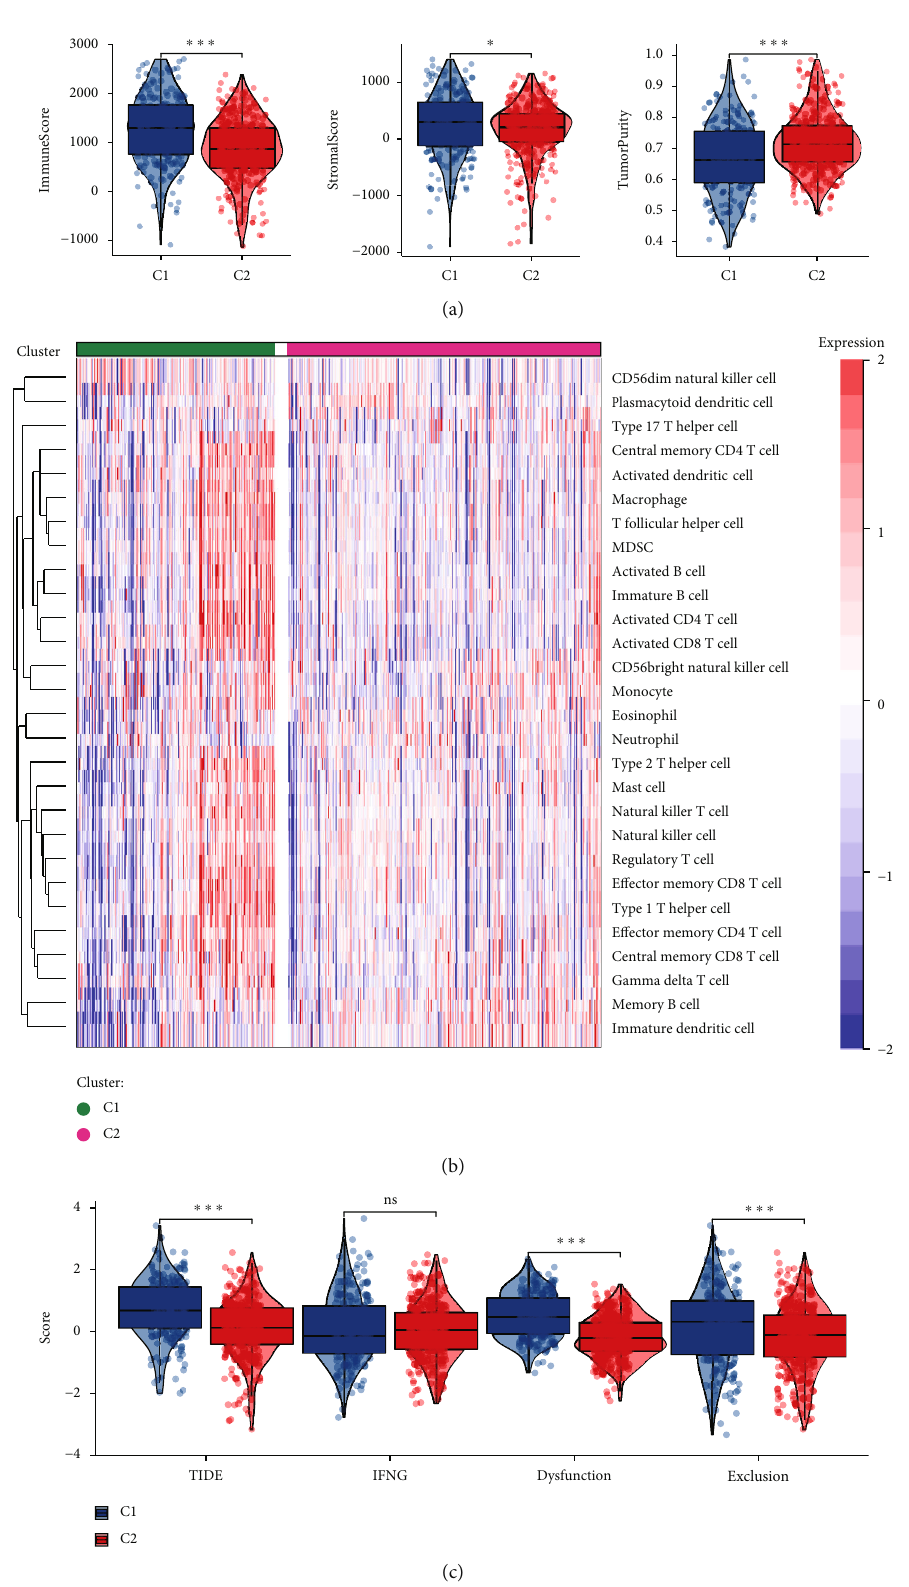
Figure 2: The immunological variation between subtypes. (a) Comparison of the immune score, stromal score, and tumor purity between the clusters. (b) The GSVA results in the immune cell in fi ltration levels of the clusters. (c) Comparison of TIDE analysis results between clusters including TIDE, IFNG, T cell dysfunction, and exclusion